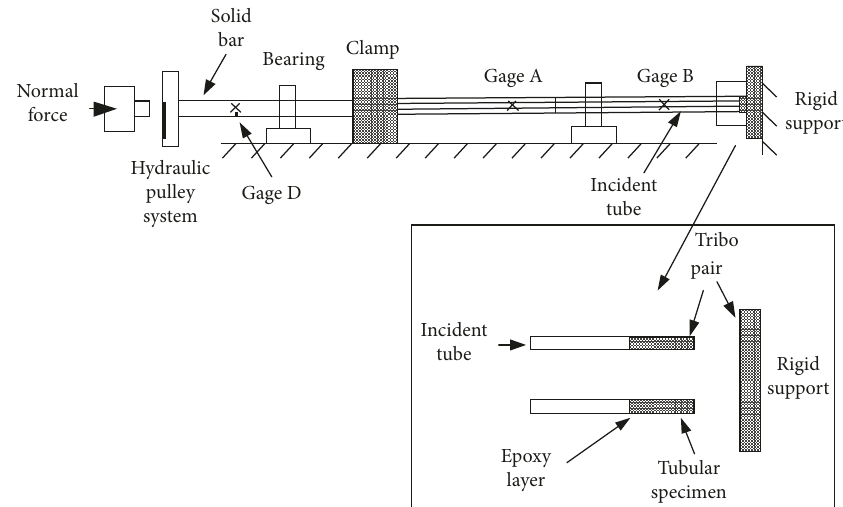
Figure 20: TSHB for static compression and dynamic torsion developed by Rajagopalan and Prakash